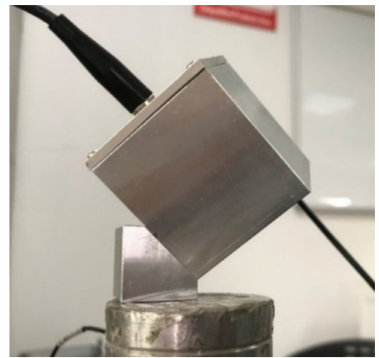
Figure 22. Installation of sensor in dynamic test experiment.